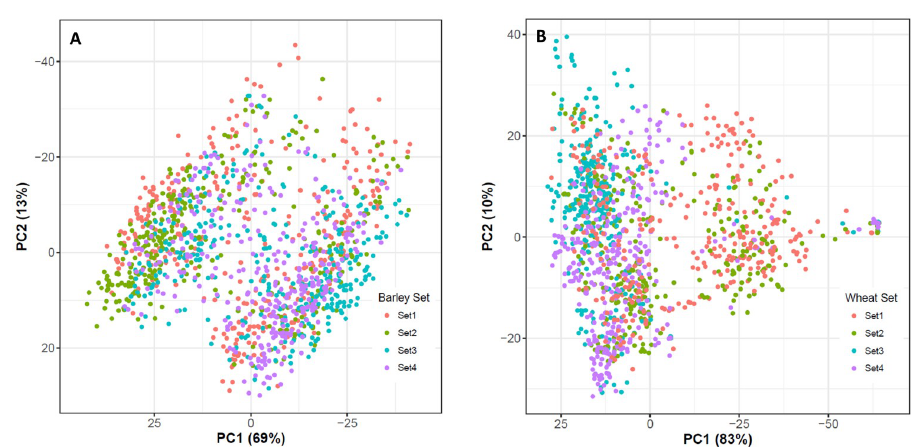
Fig 3. Principal coordinate analysis of (a) spring barley and (b) winter